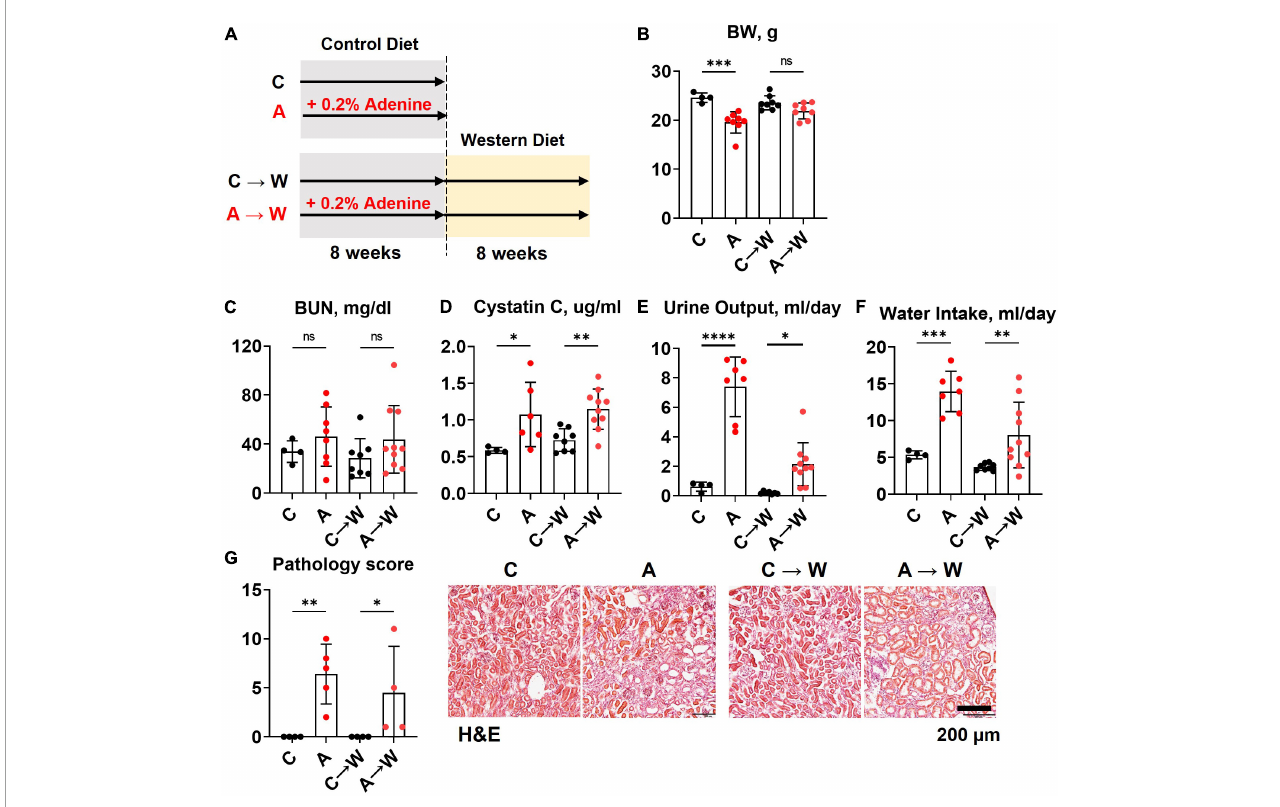
FIGURE5 Chronic kidney disease in WHC female mice pre-treated with 0.2% adenine before a western diet. (A) Schematics of the experiment: control diet (C), 0.2% adenine in a control diet (A), control diet followed by a western diet (C → W), adenine diet followed by a western diet (A → W). (B) Body weight (BW). (C) Blood urea nitrogen (BUN). (D) Plasma Cystatin C. (E) 24-h urine output. (F) 24-h water intake. (G) Renal histology scores and representative images of H&E stained slides. n = 4–10 per group; two-way ANOVA. ns, not significant; ∗ p < 0.05; ∗∗ p < 0.01; ∗∗∗ p < 0.001; ∗∗∗∗ p <